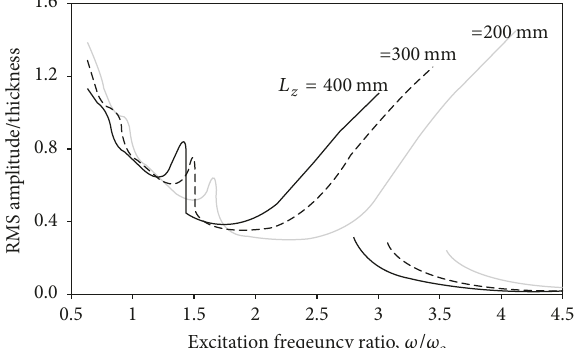
(c) Vibration amplitude versus excitation frequency for various cavity depths ( ℎ = 2 mm, 𝐿 𝑥 = 0.5 m, 𝐵 = 0.4 m, 𝜉 = 0.02 , 𝑤 𝑐 = 1